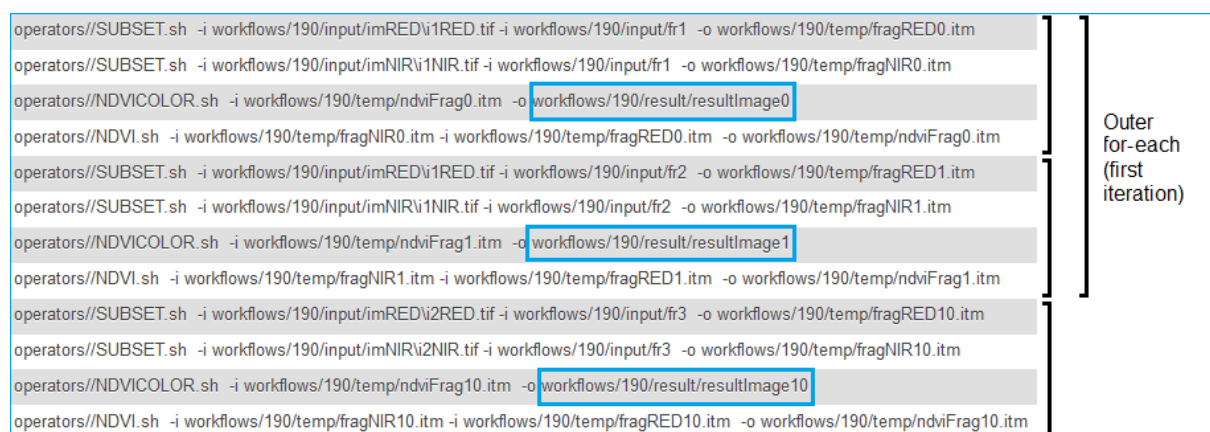
Figure 6. For-each scheduling results